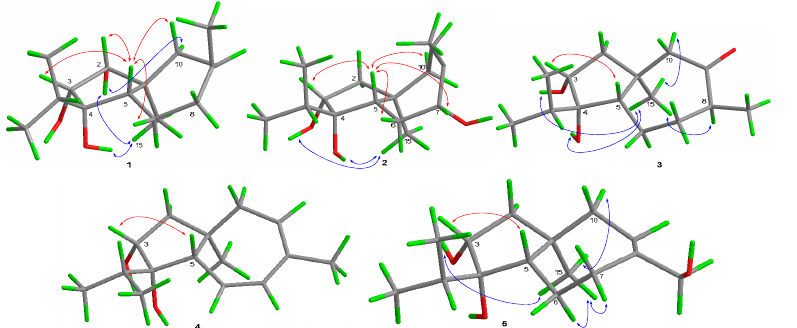
Figure 3. Key NOE correlations of compounds 1 − 5 .